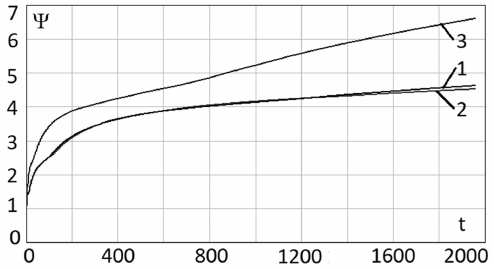
Figure 6. Error functions Ψ of the numerical solution of the test problem I in the norm L 1 depending on the length of the calculated time interval: 1—scheme (14), 2—scheme (18), 3—scheme